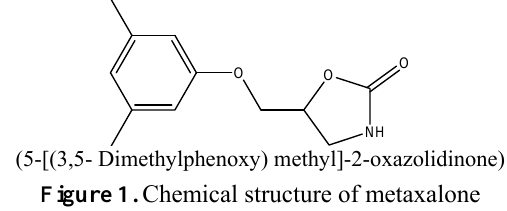
Figure 1. Chemical structure of